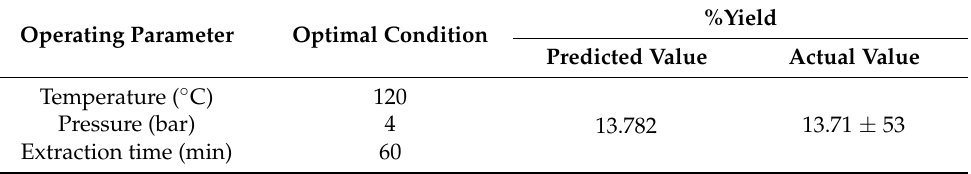
Table 4. Optimal conditions for SCGs extraction with pressurized hot water and the predicted and the actual values of response. Operating Parameter